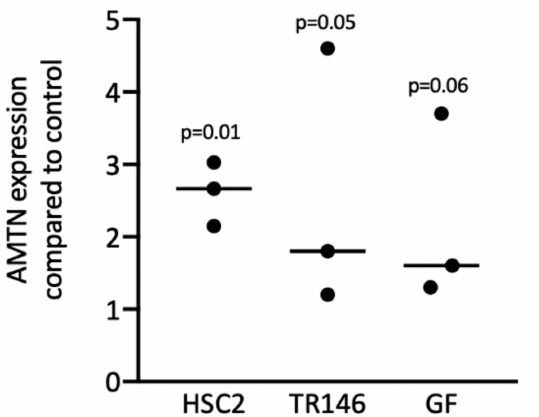
Figure 8. ADL bound to gelatin induces expression of AMTN. RT-PCR analysis showed induced expression of AMTN in comparison to untreated control in HSC2, TR146, and GF when ADL was bound to gelatin. Statistics based on one-way ANOVA Kruskal–Wallis test, comparing treated samples to the untreated control.